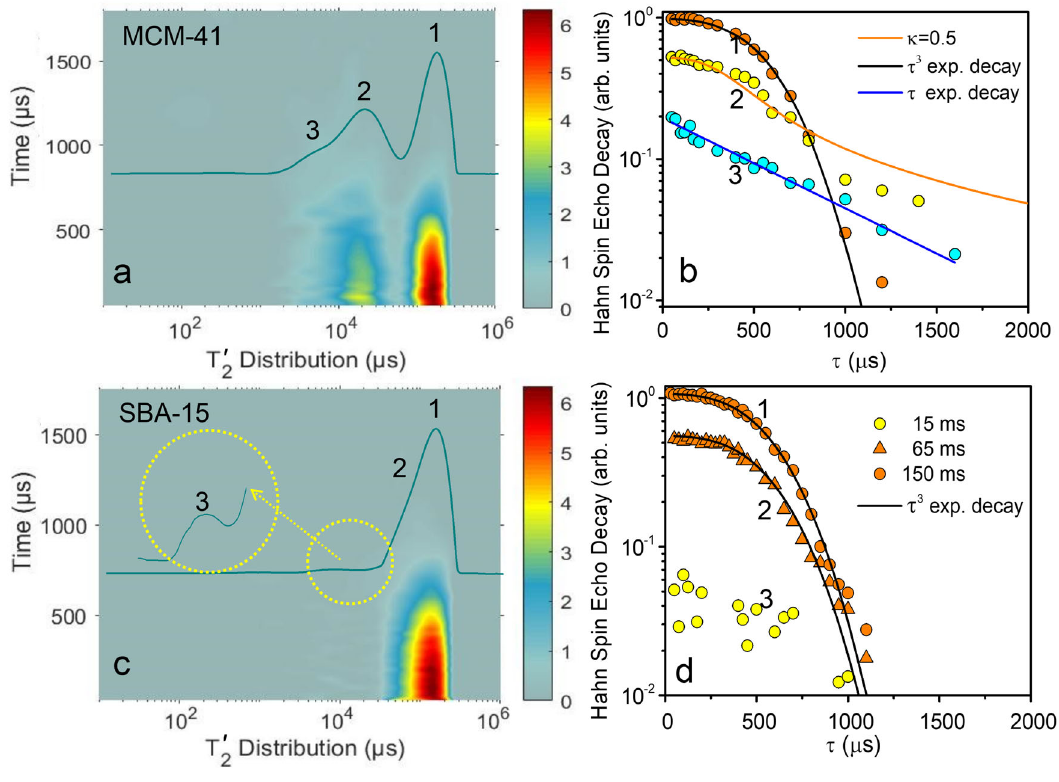
Fig. 3 1 H NMR T 0 -resolved Hahn SEDs of oversaturated [BMIM] + [TCM] − /MCM-41 and SBA-15 ionogels at RT. a Hahn SEDs across the 1 H NMR T 0 2 2 distribution of the MCM-41 ionogel. The dark cyan line is the projection of the signal intensity on the T 0 -axis. Three signals are observed corresponding to 2 external bulk (signal 1), con fi ned mobile (signal 2), and adsorbed (signal 3) [BMIM] + cations. b The Hahn SED vs. τ of signals 1, 2, and 3 in Fig. 3a. As in Fig. 3, signal 1 follows unrestricted diffusion (black line), signal 2 exhibits SFD (orange color line), while signal 3 is decaying exponentially (blue line), as expected for immobilized cations. c 1 H NMR Hahn SED across the T 0 distribution of the SBA-15 ionogel. The dark cyan line is the projection of the signal 2 intensity on the T 0 -axis. Signals 1 and 2 belong to the external bulk [BMIM] + cations, whereas only a very weak signal of [BMIM] + entrapped into SBA-15 2 is observed, due to the high dilution. d The Hahn SED of signals 1 and 2 follow unrestricted diffusion (black lines).